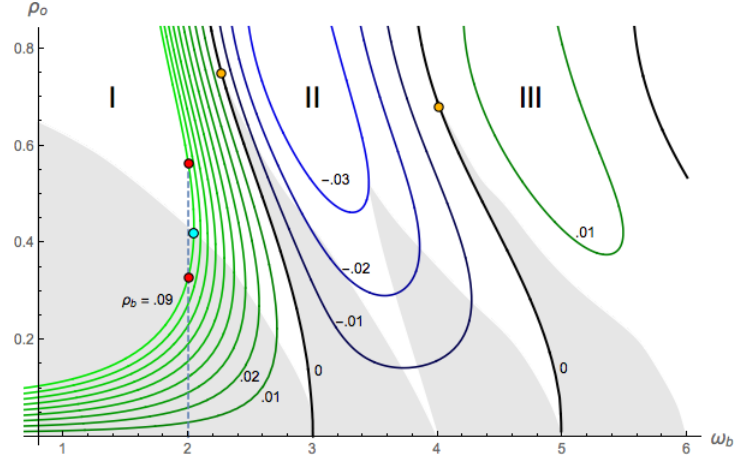
Figure 4 . Level curves of the SPS surface plotted in (cid:12)gure 2. Each curve corresponds to a constant value (cid:26) b (sometimes reported explicitly by a small number near the curve). The black curves denote the boson stars with (cid:26) b = 0. The two red points both correspond to ! b = 2 and (cid:26) b = 0 : 09. The cyan dot represents the point where ! b reaches its maximal value along the level curve. The dark yellow dots mark the stability thresholds along the boson star lines.